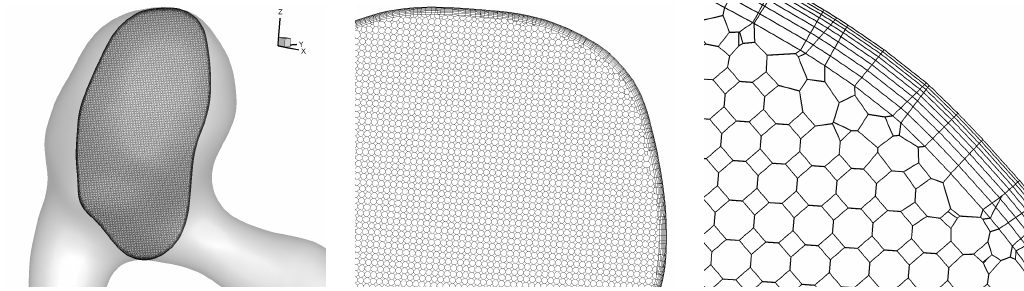
Figure 1. Cross-section through aneurysm of Case 1, showing details of the prism layers and polyhedral